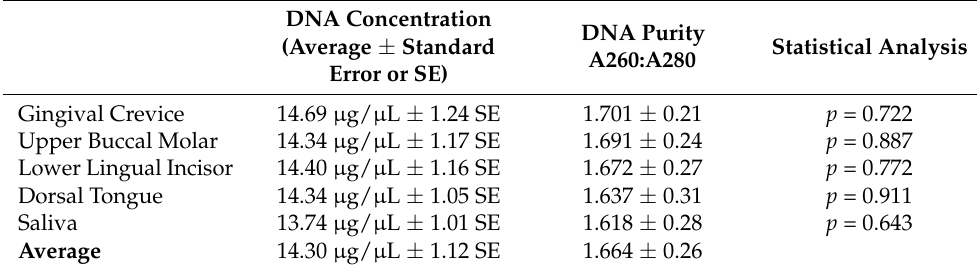
Table 2. Analysis of DNA isolated from study samples.